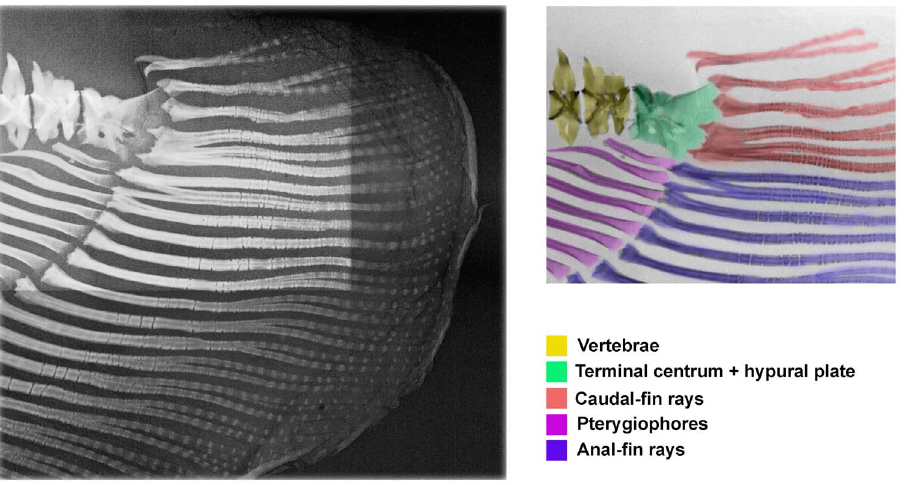
Figure 3. Radiographic image of caudal-fin region in Electrophoruselectricus, USNM 225669, 500 mm TL. Color coding indicates components of caudal-fin skeleton, caudal-fin rays and posterior portion of anal fin.